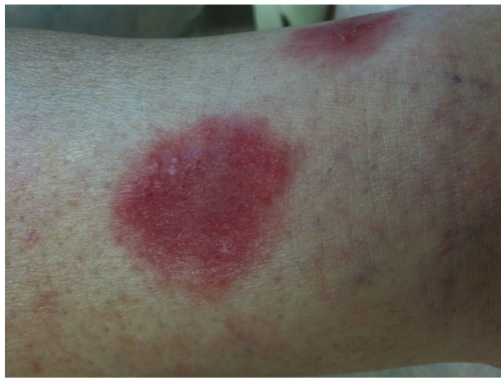
Figure 1: Erythematous and vesicular plaque on the shin.